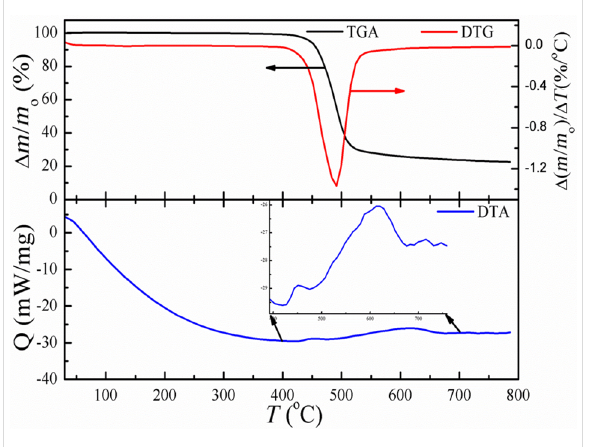
Figure 5: TGA/DTG and DTA analysis of the PC/MWCNT films at 1 wt % loading under N 2 flow. The inset in the lower panel shows the zoomed image of the DTA plot in the region of highest mass